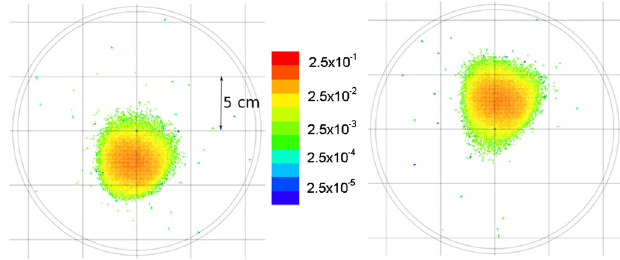
value.FIG. 14. Two characteristic beam profile cases during beam rotation with a phase shift of 180°. On the left the directional kick is 10°, on the right